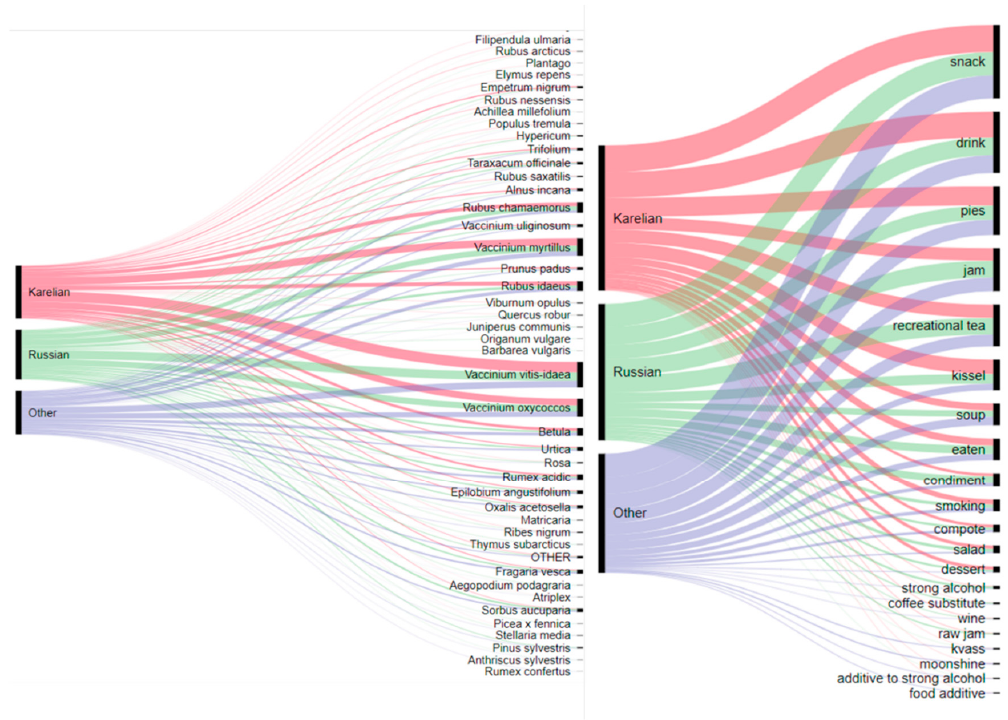
Figure 5. Alluvial diagram illustrating the distribution of plants and uses among the three groups.